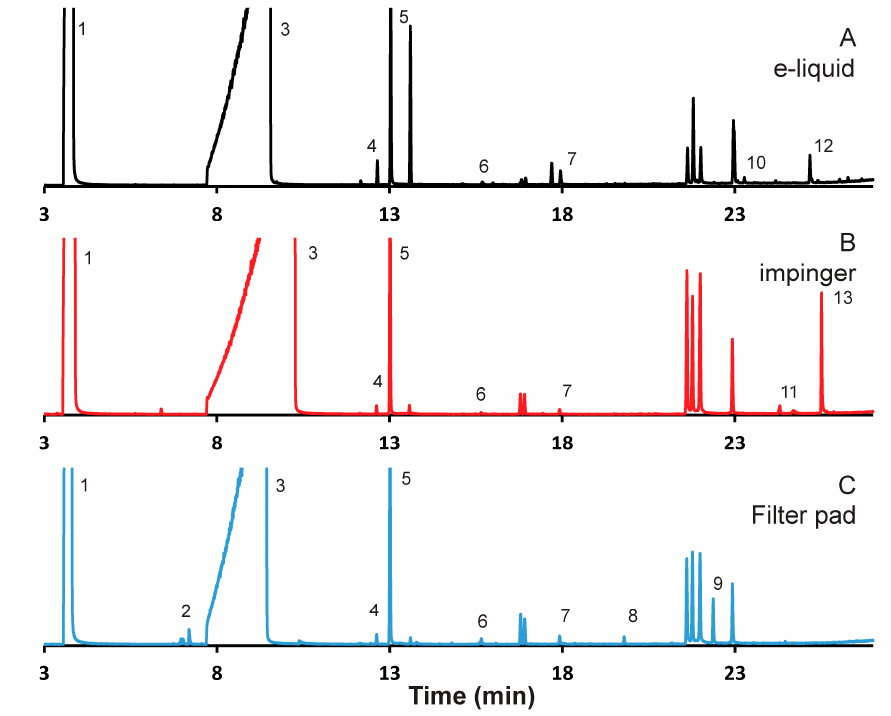
Figure 3. Gas chromatogram (GC) analysis of aerosol emissions resulting from cinnamon flavored e-liquid using alternative captured methods. Emissions were collected from 100 puffs under realistic topography conditions. Chromatograms reflect ( A ) E-liquid diluted in methanol, and emissions collected: ( B ) with series impinger 1; and ( C ) on 10 Cambridge pads, with 10 puffs per pad.